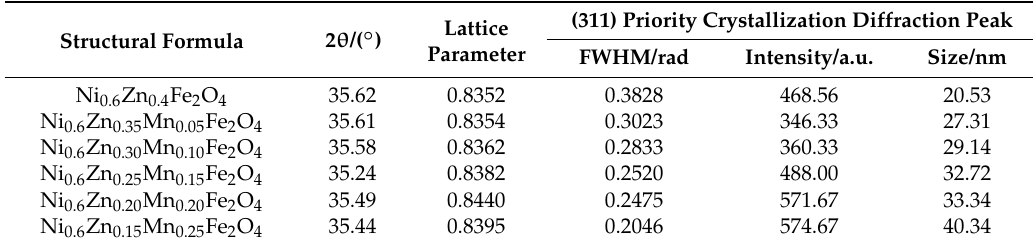
Figure 5. X-ray diffraction graph patterns of samples prepared with different Mn 2+ content ( a ) and without Mn 2+ content ( b ). Table 2. Composition and structure parameters of